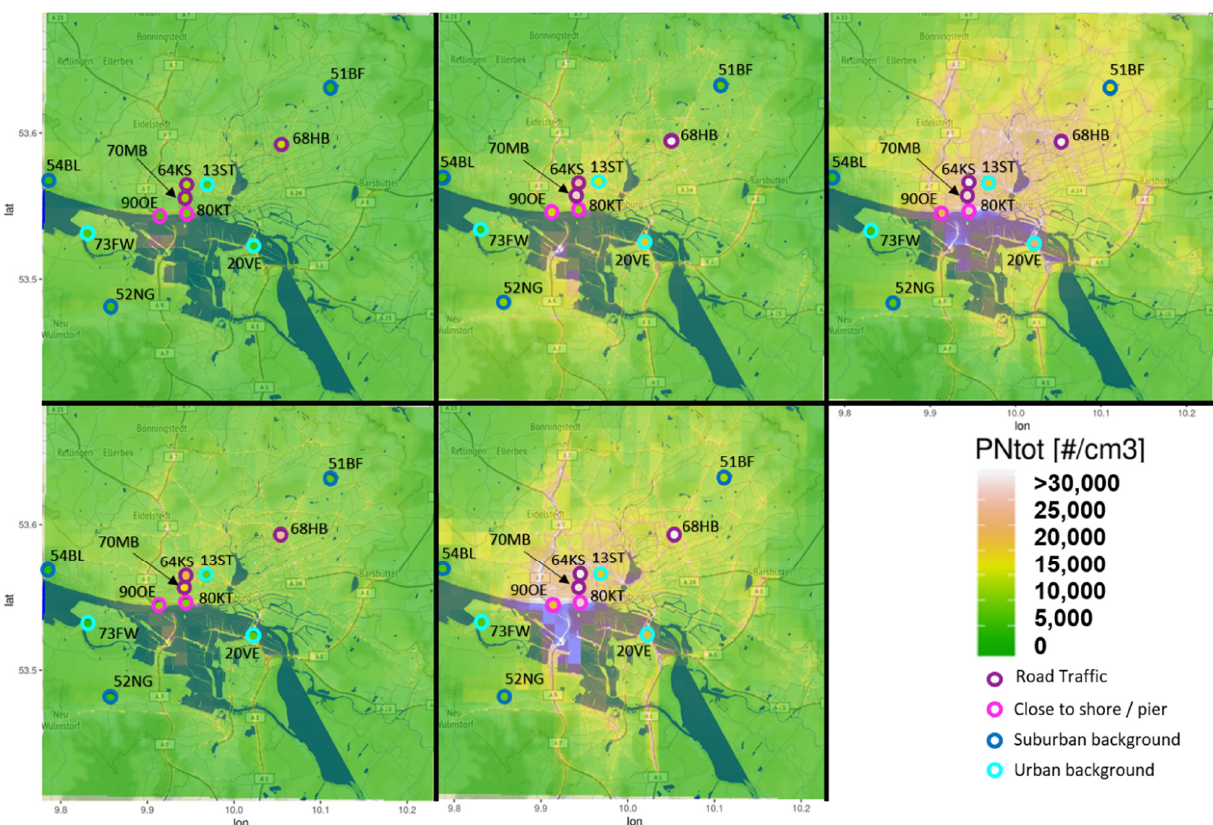
Figure 4. Modelled average particle number concentration (in cm − 3 ) in the Hamburg urban area on five days in February; area: 30 × 30 km 2 , resolution: 1 km 2 ; blue: Water and harbor area. Circles indicate the locations of stations of the Hamburg air monitoring network. A list of the station acronyms is given in Table A1. The color of the circle outline indicates the station category that the station belongs to (dark blue: suburban; cyan: urban background; purple: road traffic; magenta: close to